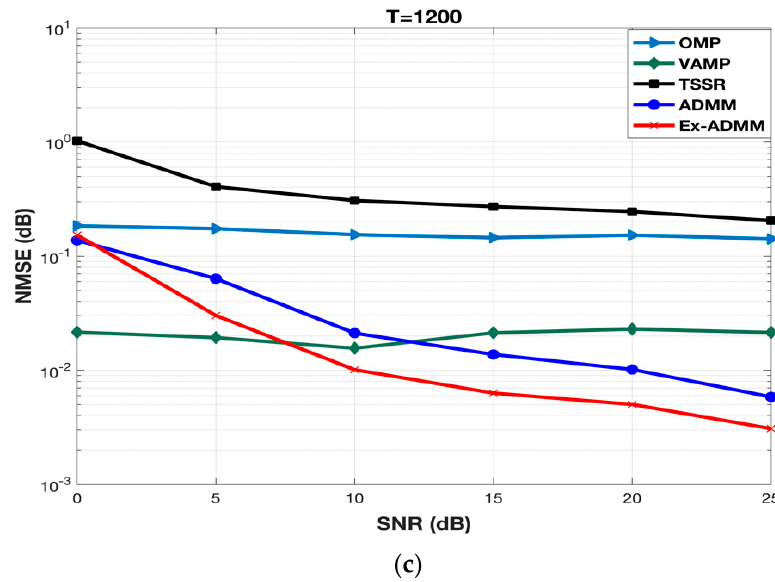
Figure 3. ( a – c ) NMSE for different transmit SNRs for a 64 × 64 mmWave MIMO channel at T = 400, T = 800 and T = 1200 .